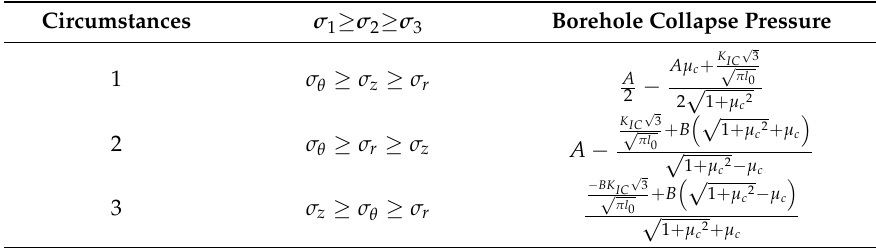
Table 8. Critical collapse pressure for the fissured borehole wall.